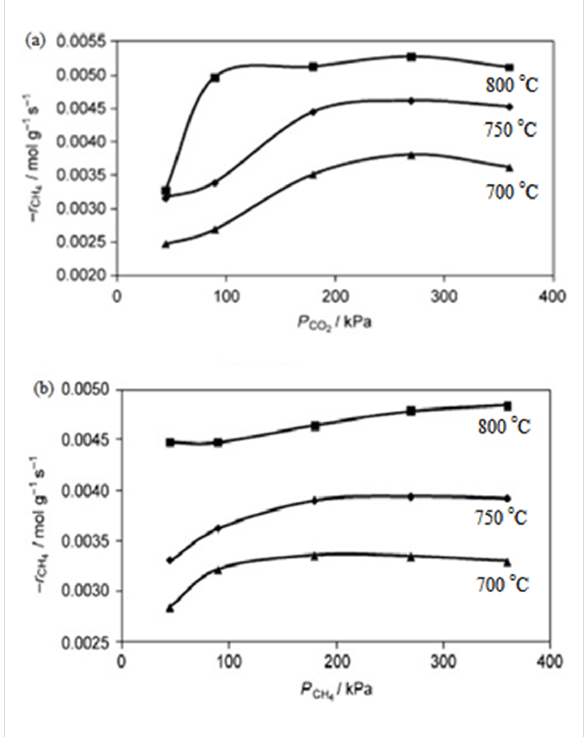
Figure 4: The partial pressure effect of (a) CO 2 and (b) CH 4 on the rate of CH 4 reforming; P CO2 = 90 kPa. Reprinted with permission from [3], copyright 2011 Elsevier.